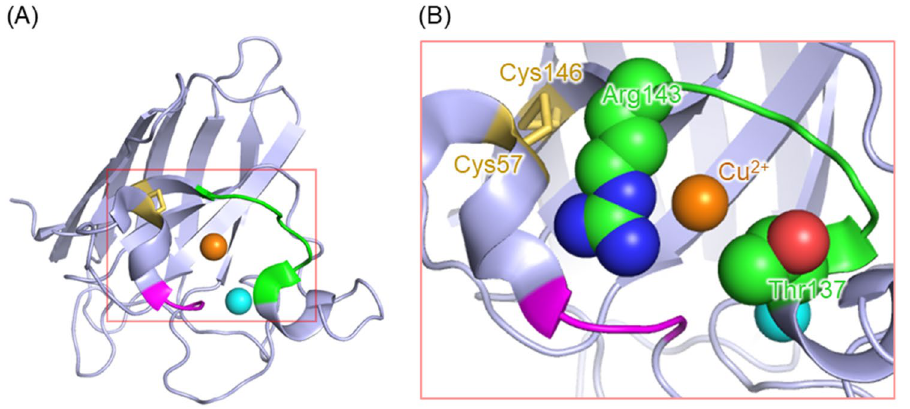
Figure 5. Overall structure and catalytic site of wild-type SOD1 (PDB code: 1PU0 26 ). ( A ) Overall structure. ( B ) Close-up of the region indicated with a red box in ( A ) which includes the Cu-binding site (orange sphere), the intramolecular disulfide bond (yellow sticks), and the Zn - binding and electrostatic loops (pink and green